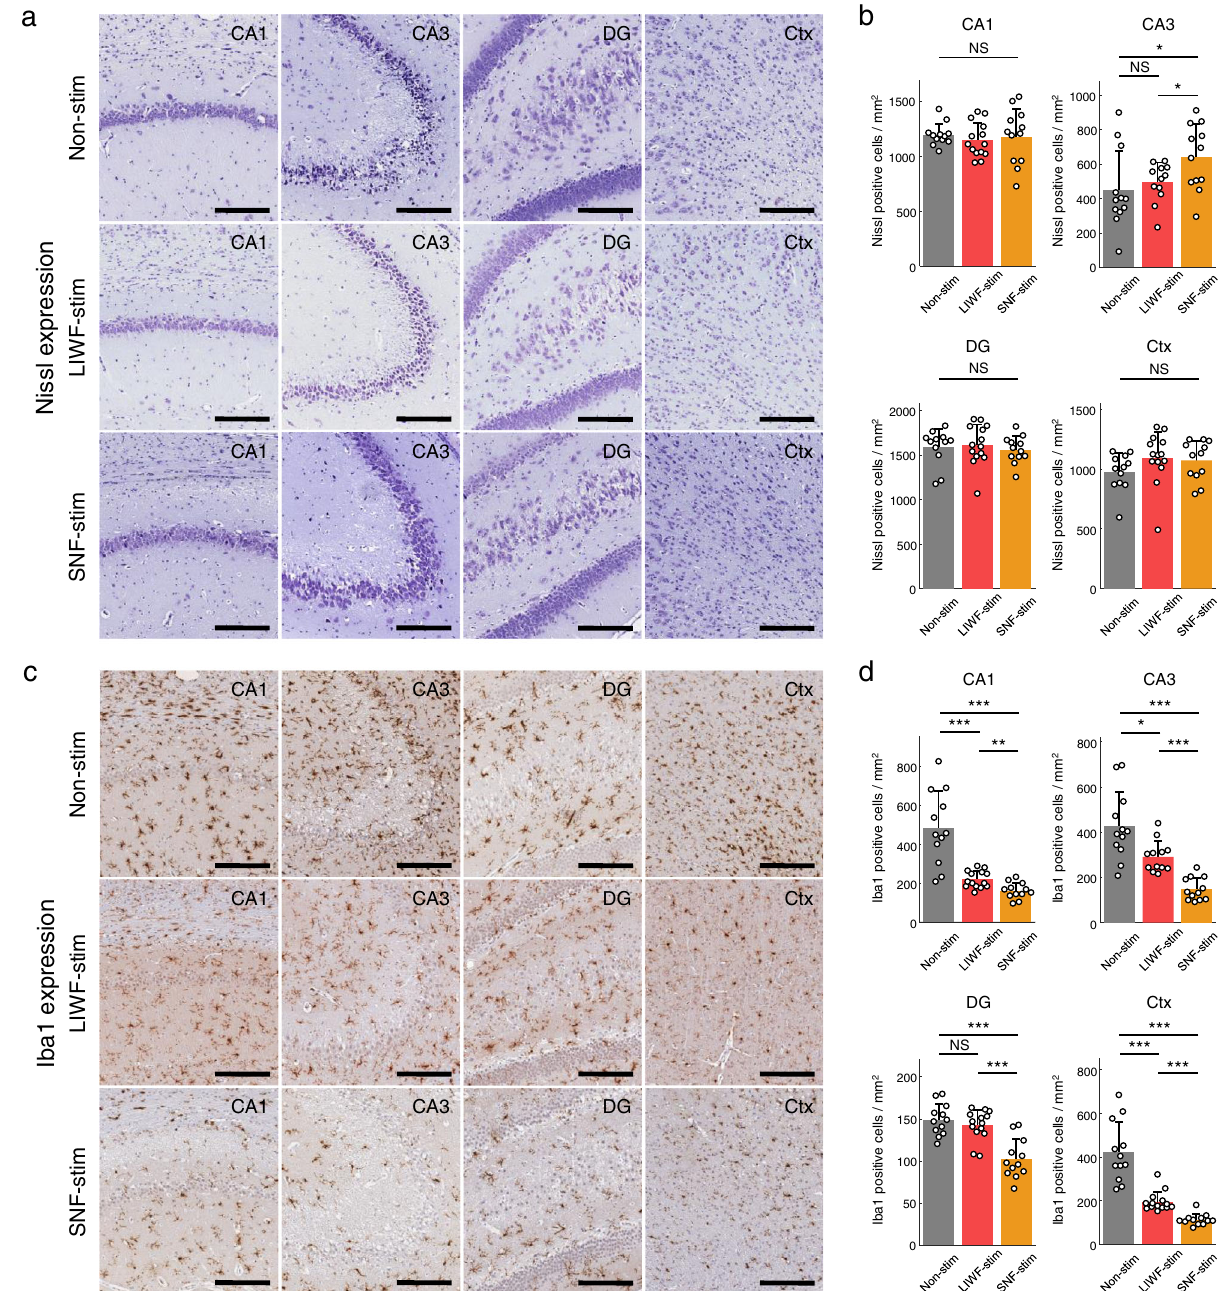
Fig. 7 | Evaluation ofneuronaldamage and neuroin fl ammation. a – d Analysisof Nisslstaining( a , b )andIba1immunoreactivity( c , d )intherodentbrainsafteracute seizure induction. a , c Representative histological sections stained with Nissl and Iba1 of the brain regions including the CA1, CA3, DG, and cortex ( n =6 rats per group). b Quanti fi cation of Nissl positive cells (intact neurons) for the non-stimu- lation, LIWF stimulation, and SNF stimulation groups ( P =0.7833, 0.0392, 0.253, and0.7673forCA1,CA3,DG,andcortexeach, n =12 – 14samplesinallcomparisons: precise values in Supplementary Table 1, one-way ANOVA with Bonferroni